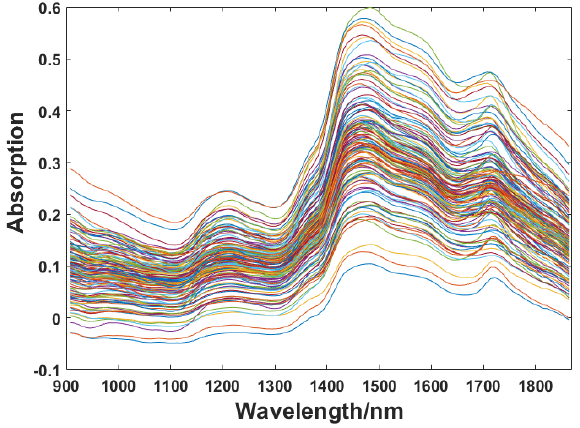
Figure 3. Raw spectra of specimens.